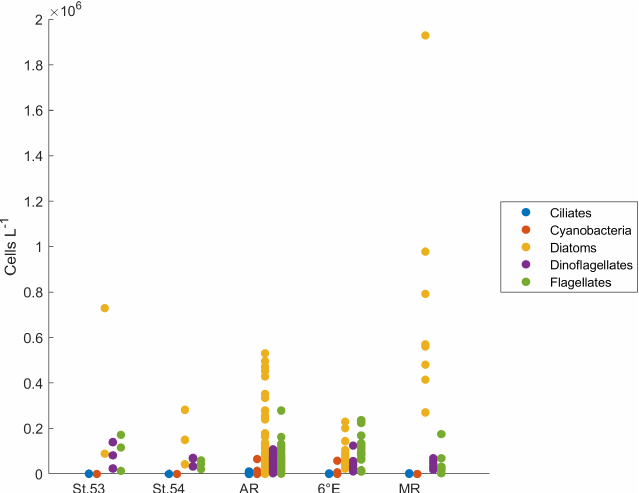
Figure A2. Protist abundance in all samples in the different sampling areas based on microscopy. St.53: station 53, St.54: station 54, AR: Astrid Ridge, 6 ◦ E: 6 ◦ E transect, MR: Maud Rise.